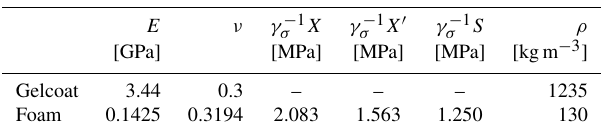
Table 2. Mechanical properties of the isotropic constituents. All strength properties are design values (not the characteristic values) and are obtained with γ σ = 1 . 92. (A larger γ σ is required by the International Electrotechnical Commission – IEC – IEC-61400-1, 2005, for the foam.)